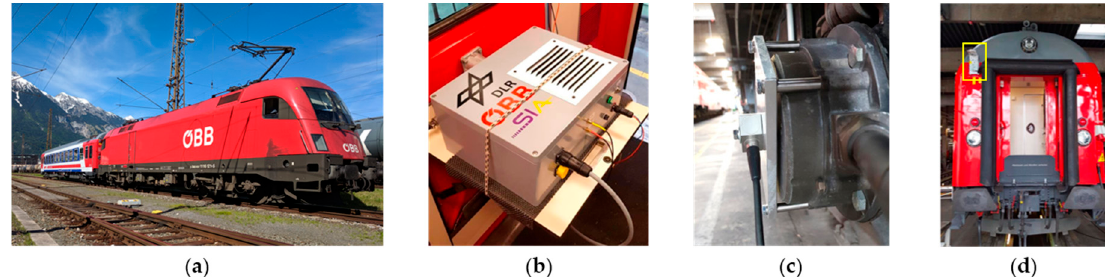
Figure 3. ( a ) Measurement train; ( b ) Multi-sensor box inside the wagon; ( c ) Accelerometer mounted at the axle box; ( d ) Global navigation satellite system (GNSS) antenna (yellow box).